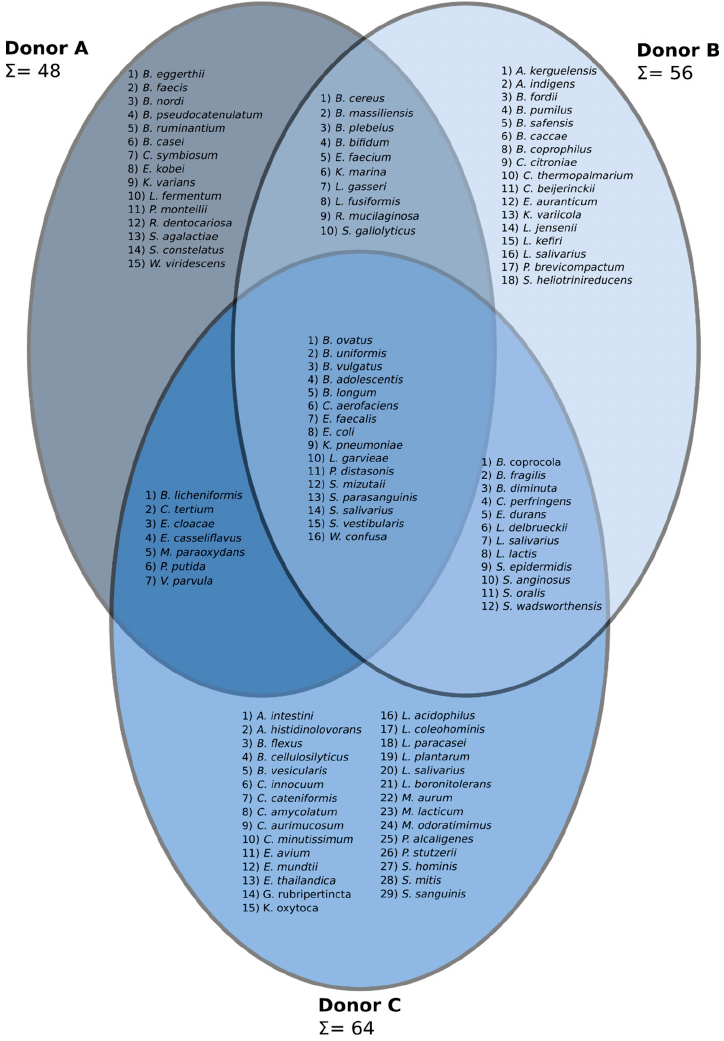
Figure 3. A three ‐ set Venn diagram constructed based on the data from a classical microbiology Figure 3. A three-set Venn diagram constructed based on the data from a classical microbiology approach. Identifiedgeneraareasfollows: Acidaminococcus ( A.intestini ), Arthrobacter ( A.histidinolovorans